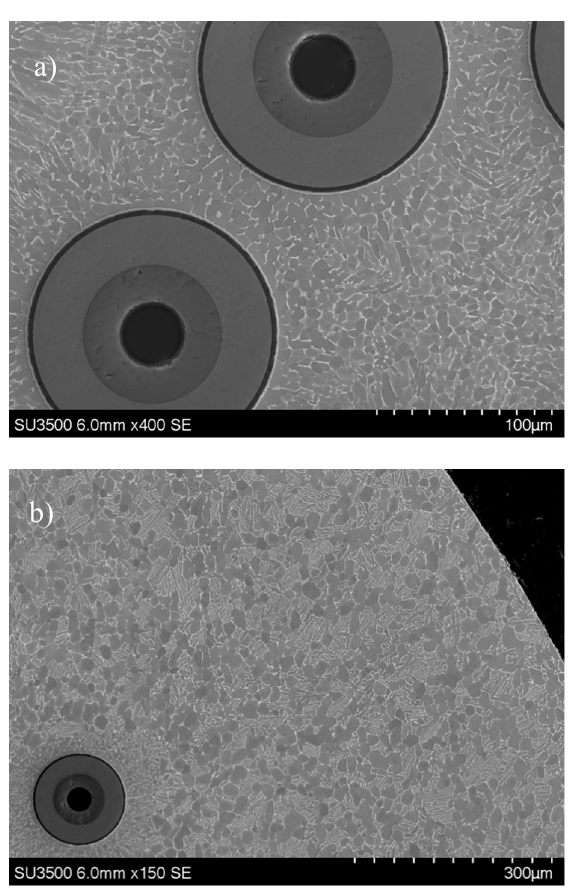
Figure 4. Microstructure of TiMMC material. A significant difference is evident between ( a ) the regions around the reinforcing fibres and ( b ) the cladding area on the outside of specimens.